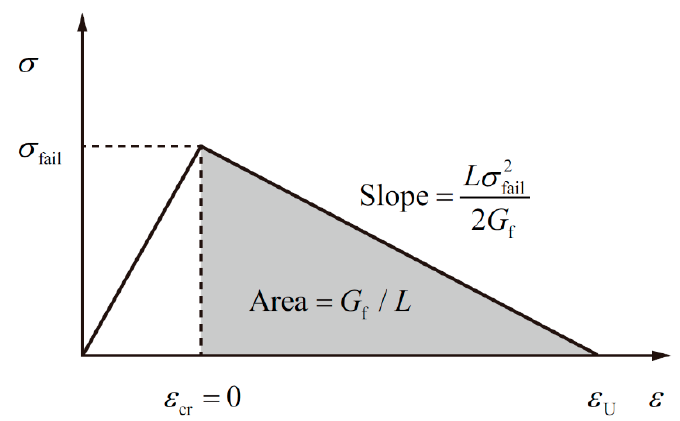
Figure 6. Schematic diagram of the crack-softening algorithm.